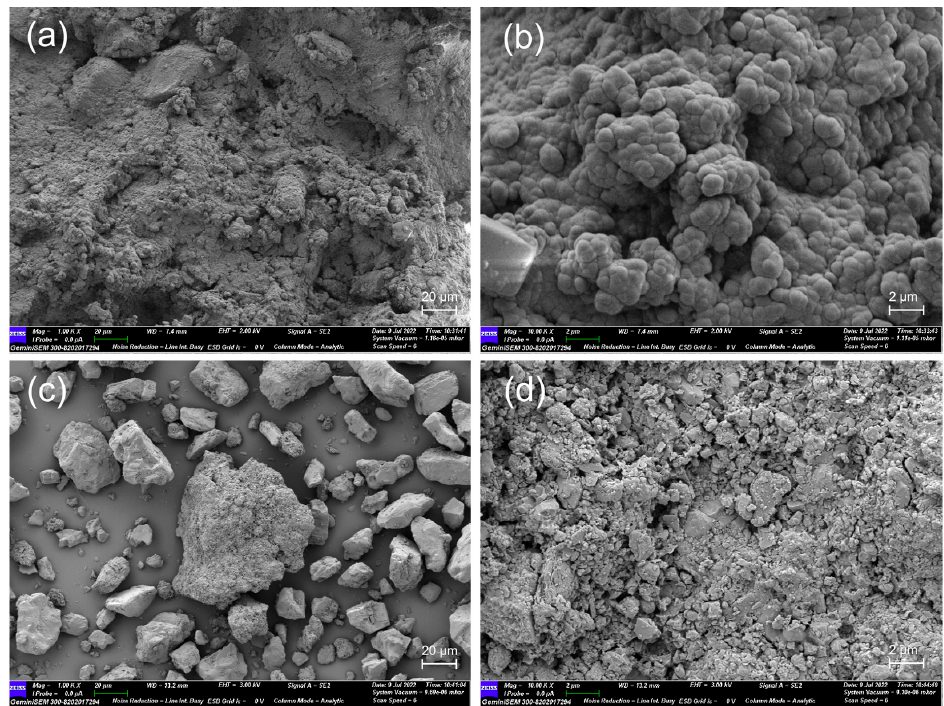
Figure 8. SEM images of shale gas OBDCs before (( a ) × 1000) and (( b ), × 10,000) and after (( c ), × 1000) and (( d ) × 10,000) treatment using SHSs.